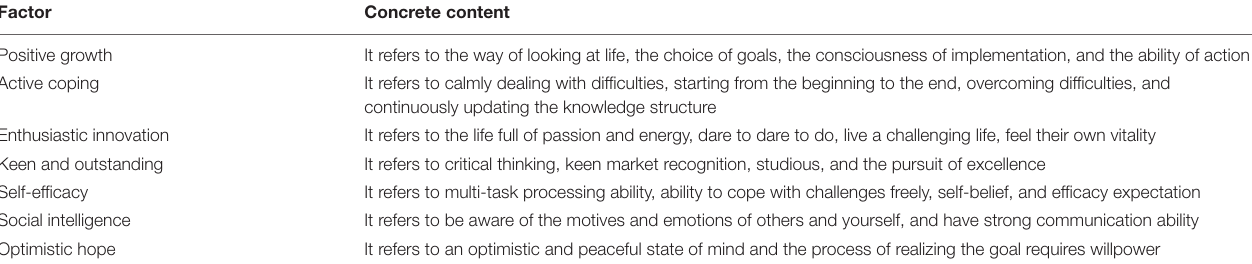
TABLE 1 | Concrete contents of the seven-factor model of psychological capital. Factor Concrete content Positive growth